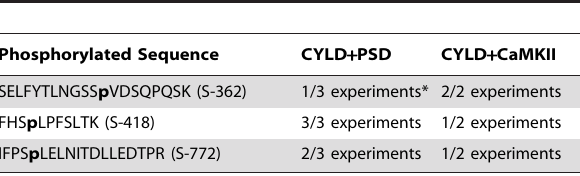
Table 1. Phosphorylated peptides of CYLD detected under CaMKII activating